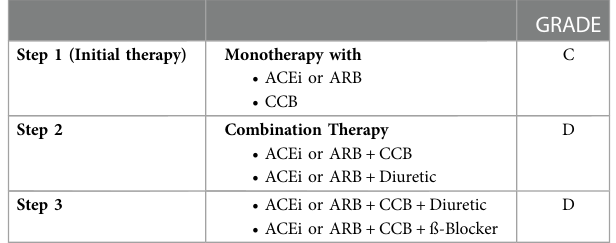
TABLE 9 Exemplary step scheme for combining antihypertensive drug classes.